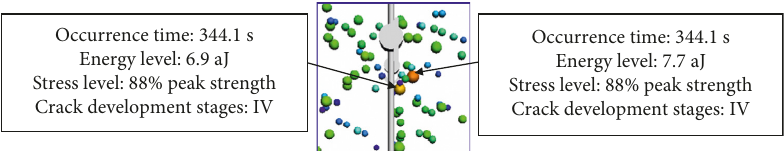
Figure 9: The spatial distribution of the AE events in the area outlined by solid lines in Figure 8(a) at 344.1s.